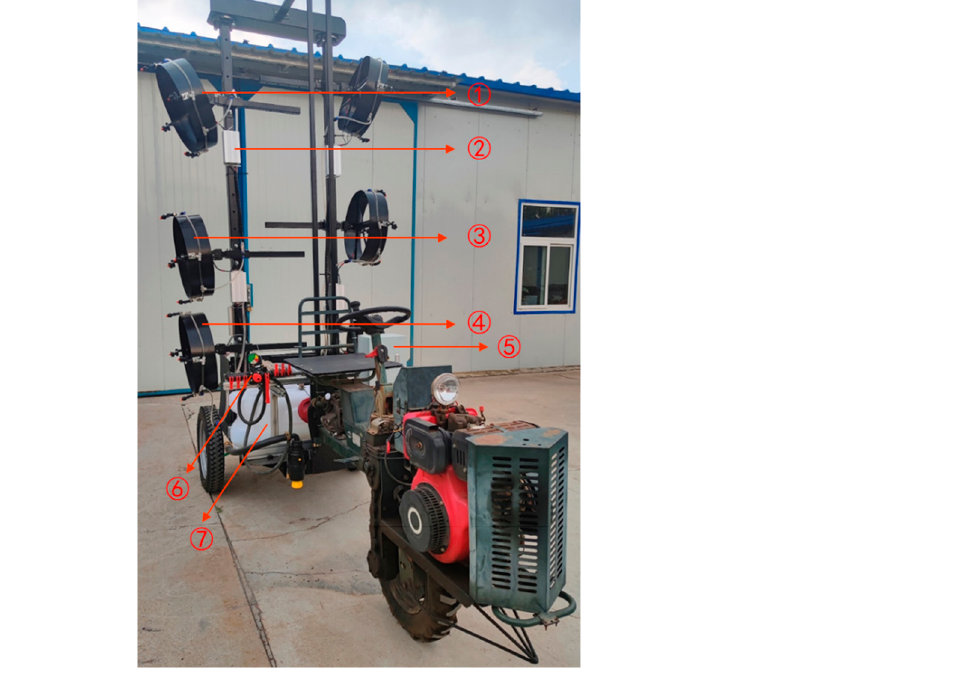
Figure 1. The multi-unit air-assisted orchard sprayer used in this study: ① Top Unit, ② Electronic Speed Control, ③ Middle Unit, ④ Bottom Unit, ⑤ Speed control box, ⑥ Proportional control valve with pressure gauge, ⑦ Tank.